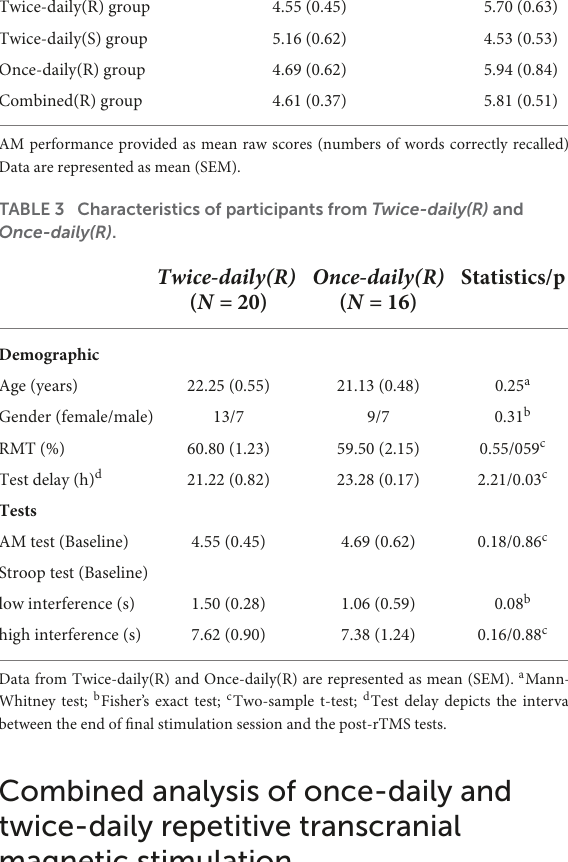
TABLE 2 Associative memory performance.